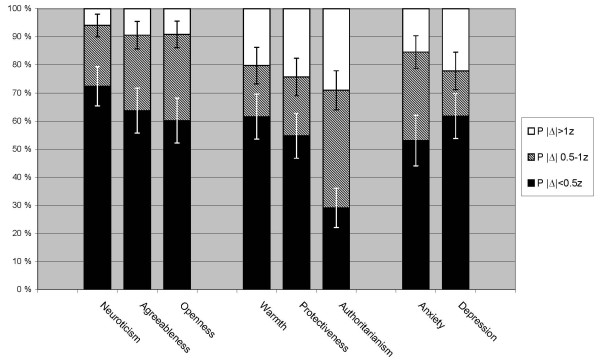
Prevalence of 'changed' P|Δ|>1z and prevalence of 'no change' P|Δ|<0.5z with 95 percentile confidence intervals indicated for both, combined in cumulative bars with the intermediate 'uncertain change' P|Δ|0.5-1z to illustrate distribution of individual stability.